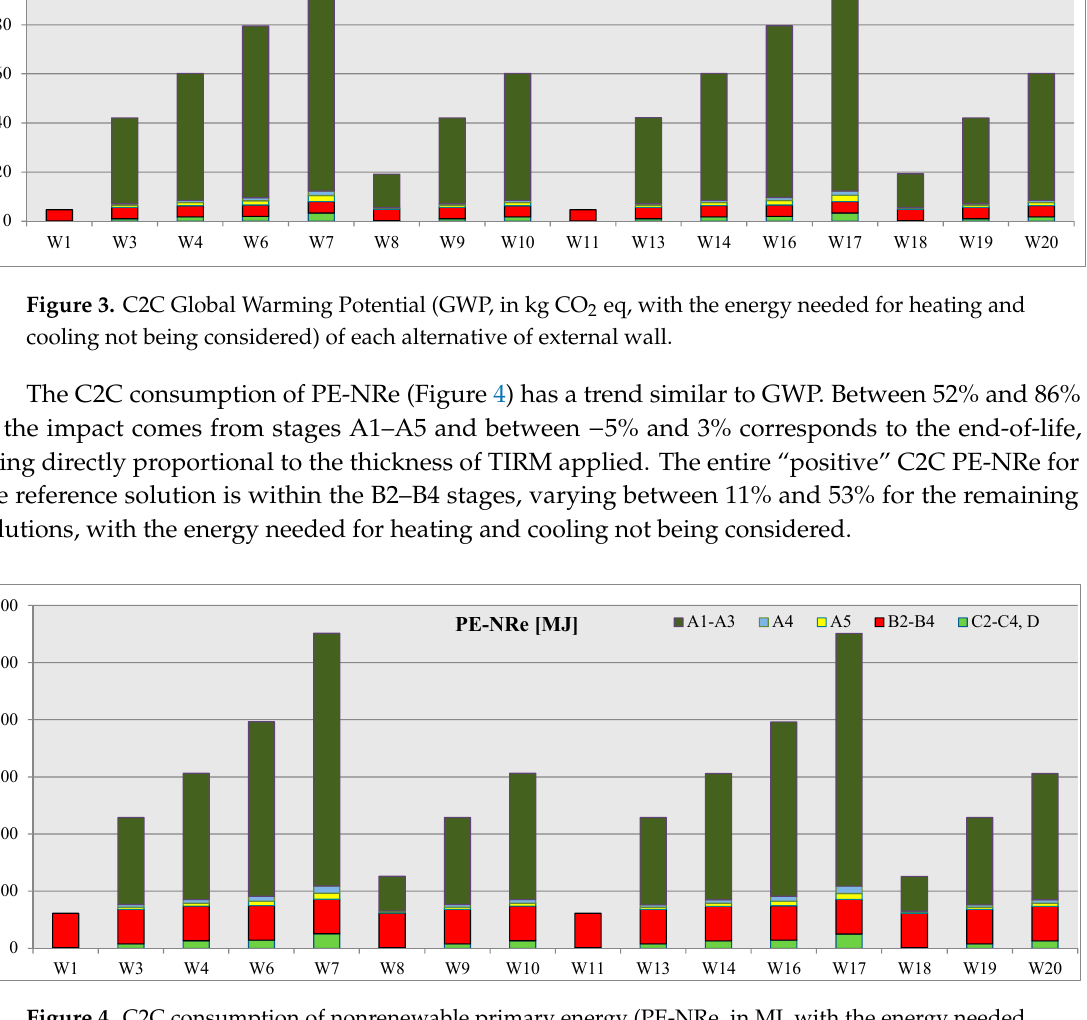
Figure 4. C2C consumption of nonrenewable primary energy (PE-NRe, in MJ, with the energy needed for heating and cooling not being considered) of each alternative of external wall.